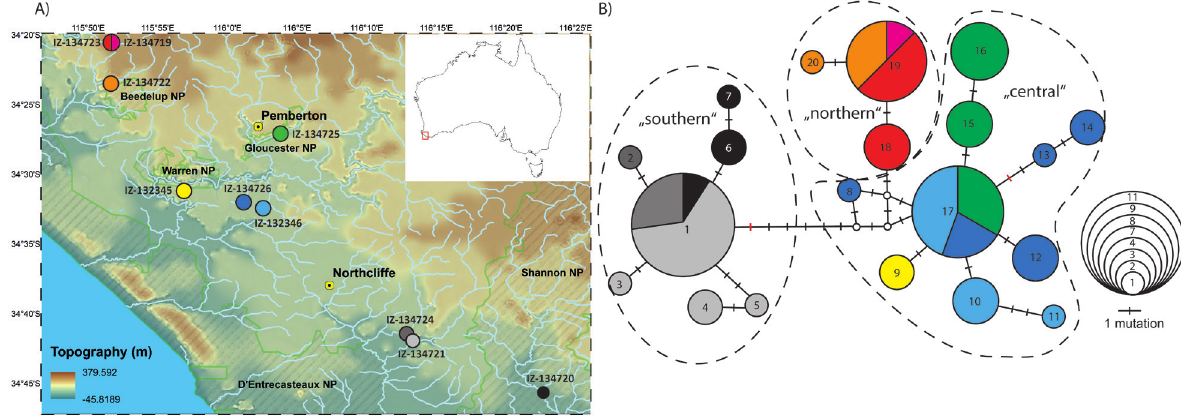
Figure 1. Distribution of haplotypes. A ) Map of sampling localities. B ) Median-joining haplotype network. Each mutation is in- dicated by a dash on the lines connecting haplotypes, mutations resulting in an amino acid changes are marked in red. The size of haplotypes correspond to their observed frequency as indicated by the scale and the colors correspond to the respective